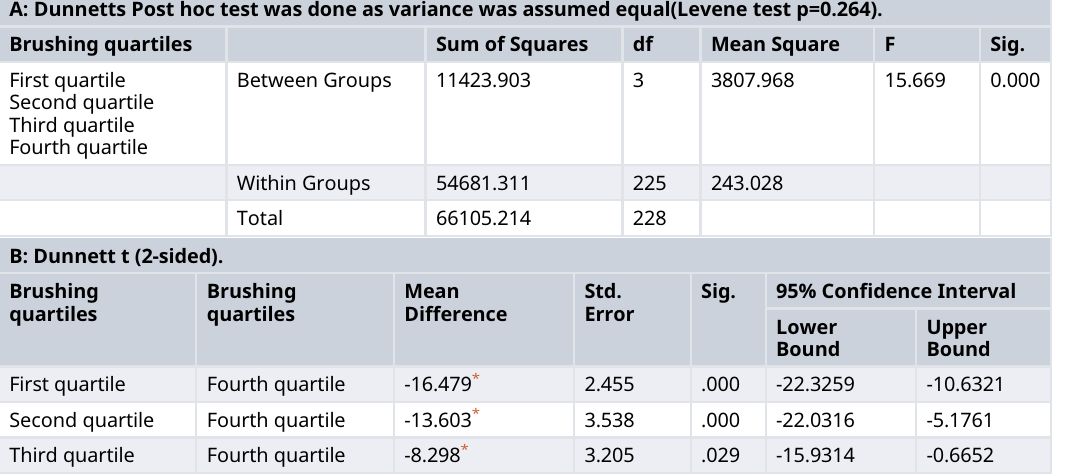
Table 3. One-way analysis of variance was carried out to compare the effect of the (independent variable) number of times a participant brushes twice daily during the week on the (dependent variable) multi theory model scale.